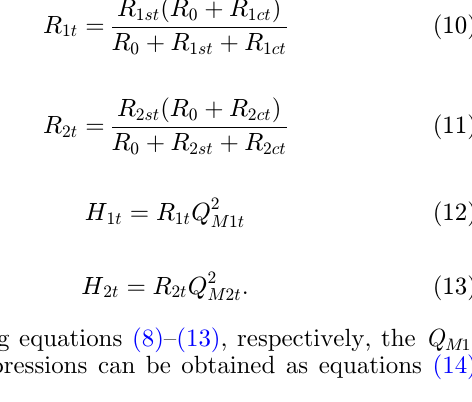
Fig. 6. Main fan air quantity-total pressure characteristic